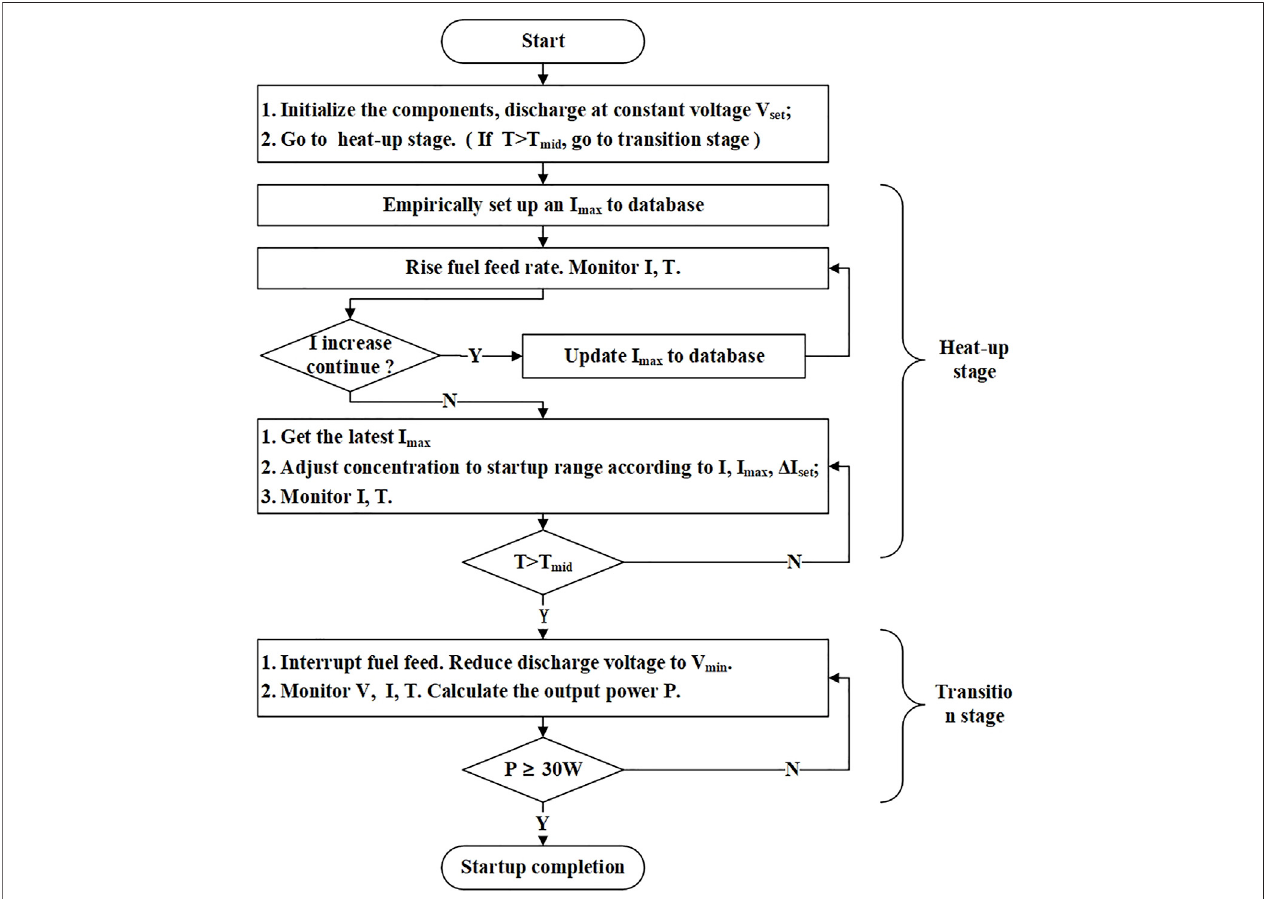
FIGURE 3 | Flow chart of the SLSC